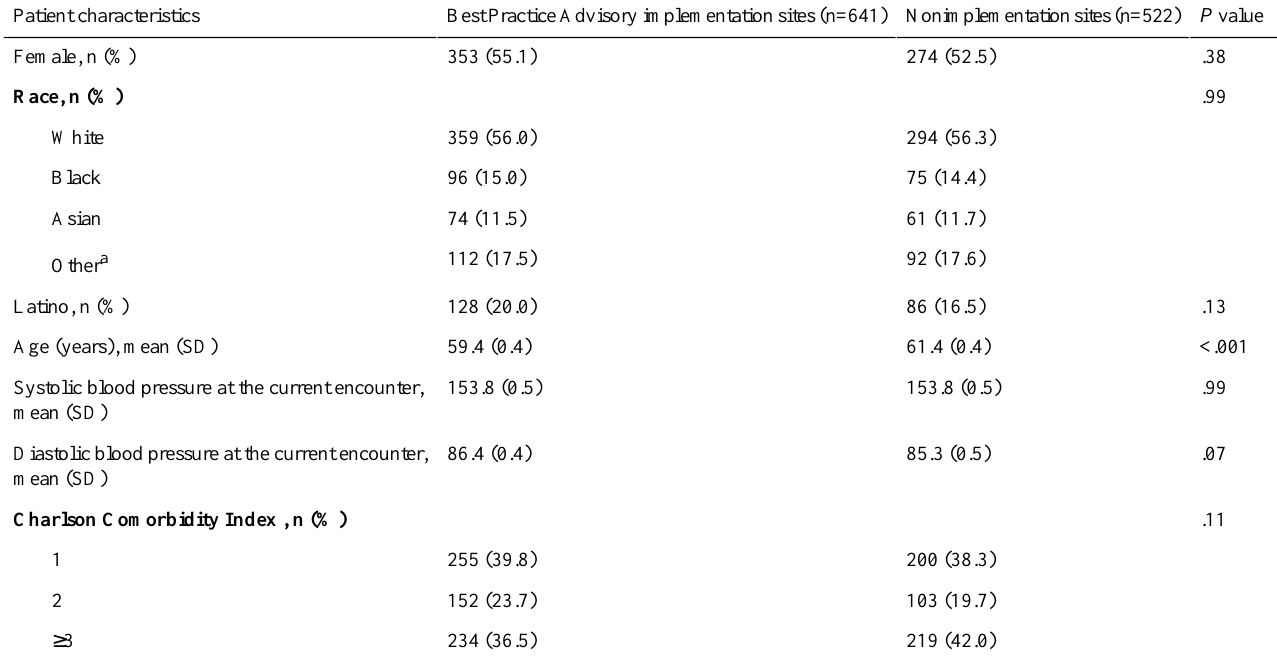
Table 2. Characteristics of unique patients at their first opportunity encounter, by Best Practice Advisory implementation